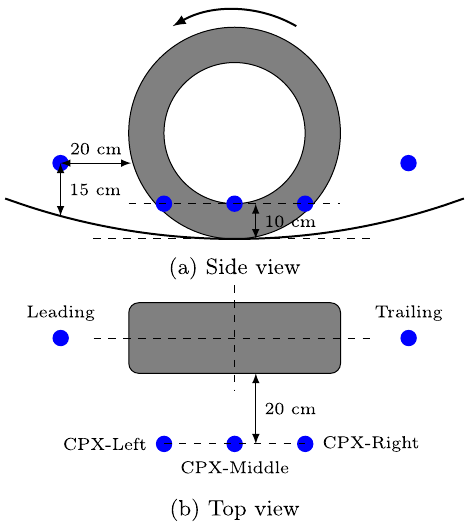
Figure 1. Microphone positions on the inner drum test bench. The thick arrow at the top of the diagram describes the standard direction of rotation.